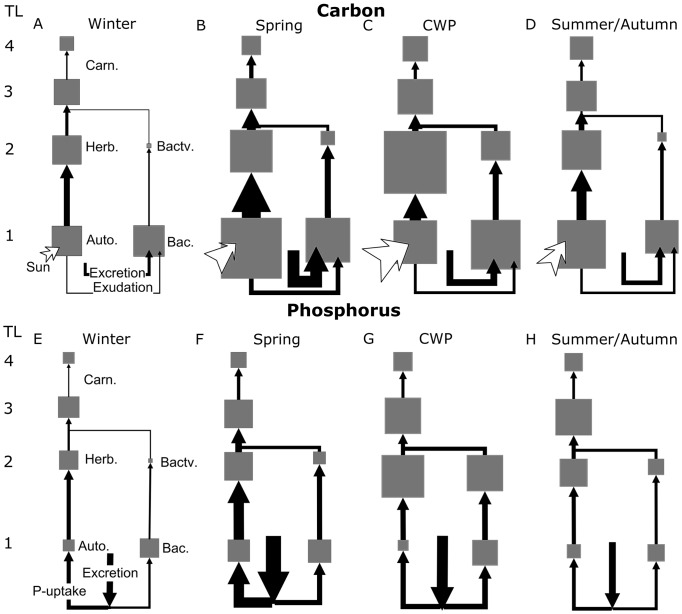
Energy (carbon) and nutrient (phosphorus) flows.(A–D) In-going flows of carbon between major compartments in winter (A), spring (B), CWP (C), and summer to autumn (D). Data from winter (phases 1+7) and summer and autumn (phases 5+6) were pooled to summarize similar flow schemes. Functional guilds aggregated into trophic compartments (see Methods). Auto.  =  Autotrophs, Herb  =  Herbivores, Carn  =  Carnivores, Bac  =  Heterotrophic Bacteria, Bactv  =  Bacterivores. Excretion summarizes the release of dead particulate and dissolved organic matter (PDOM) by phytoplankton exudation, the consumers' feeding and metabolic activities (including sloppy feeding and non-grazing mortality). Arrows widths (compartment areas) are scaled relatively to the square root of the strength of the C-flows in µgC m-2 d−1(C-content of biomass in µgC m−2). (E–H) Phosphorus (P) flows between major compartments in winter, late spring, CWP, and late summer to autumn. Seasonal scaling for P is analogous to C.